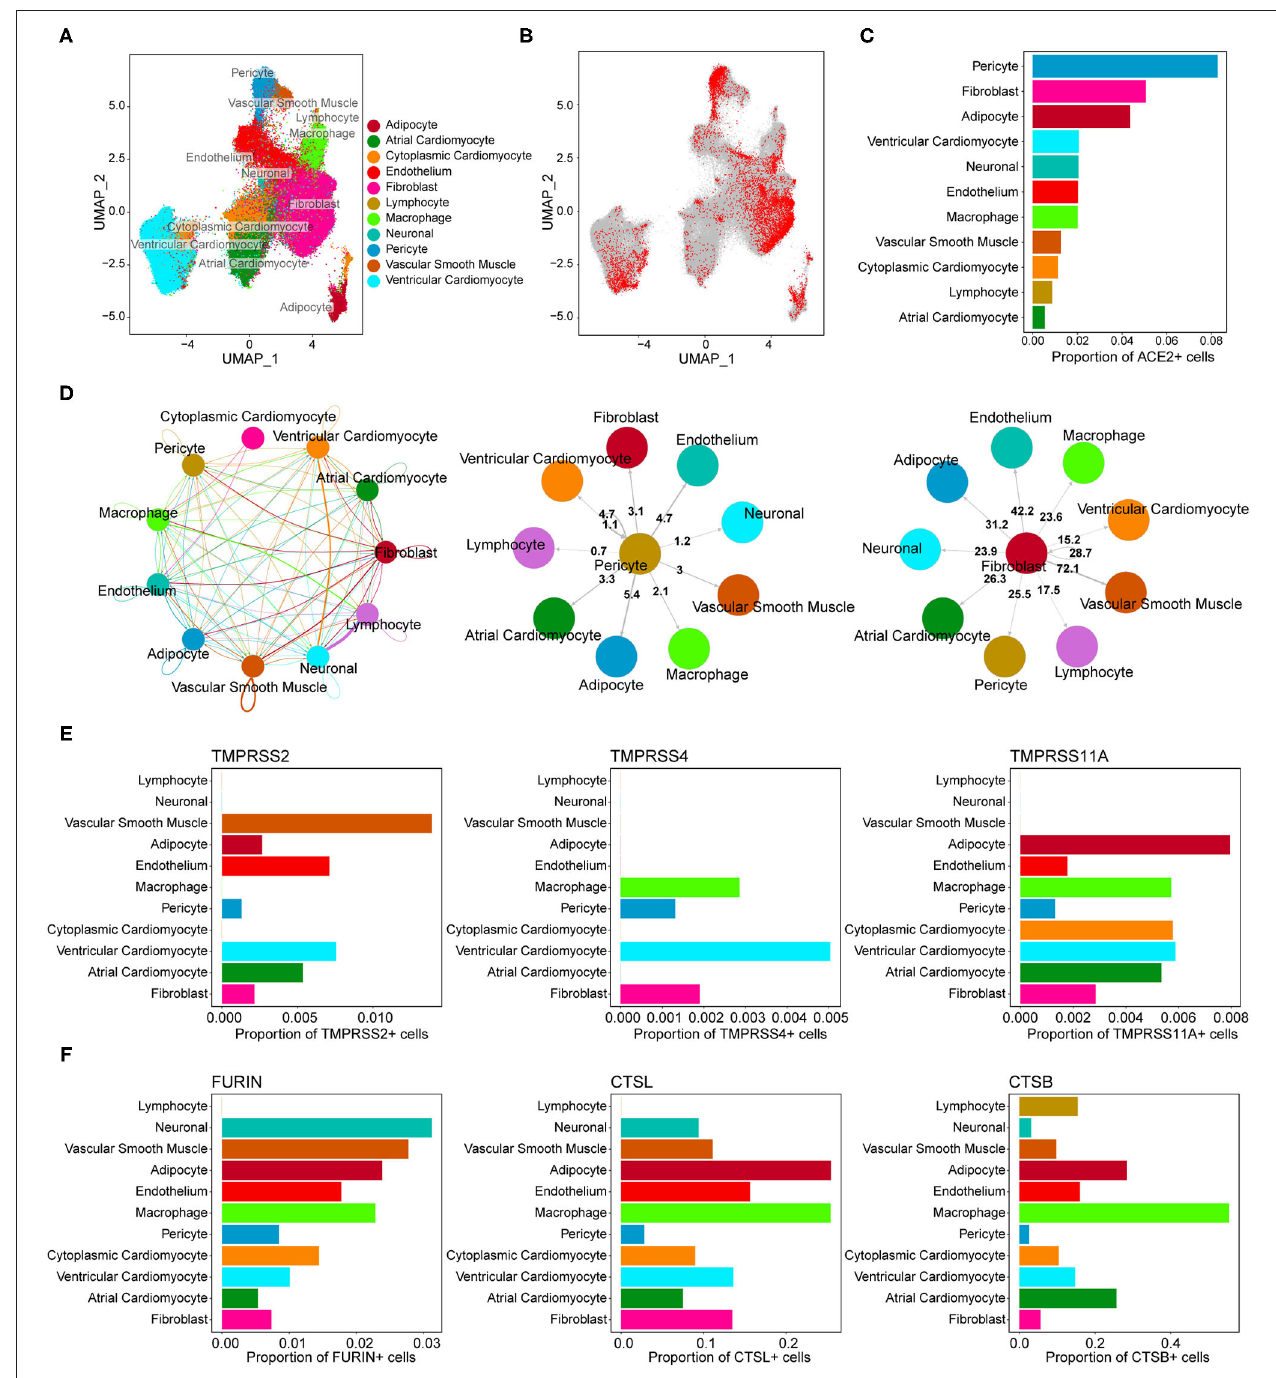
FIGURE 1 | Gene expression characterizations of angiotensin-converting enzyme 2 (ACE2) and its co-receptors in the human heart. (A) Uniform manifold approximation and projection (UMAP) plot of cell clusters in the human heart. (B) Feature plot of ACE2 expression across all cell clusters. (C) The proportion of ACE2-positive cells in each cell population. (D) Reciprocal interaction network between different cell types. (Middle panel) Cell-cell interaction between pericyte (ligand) and other cell types (receptors). (Right panel) Cross-talks from fibroblast to other cell types. (E,F) The co-expression percentage of ACE2 and accessory proteases, such as TMPRSS2, FURIN, CTSL, and